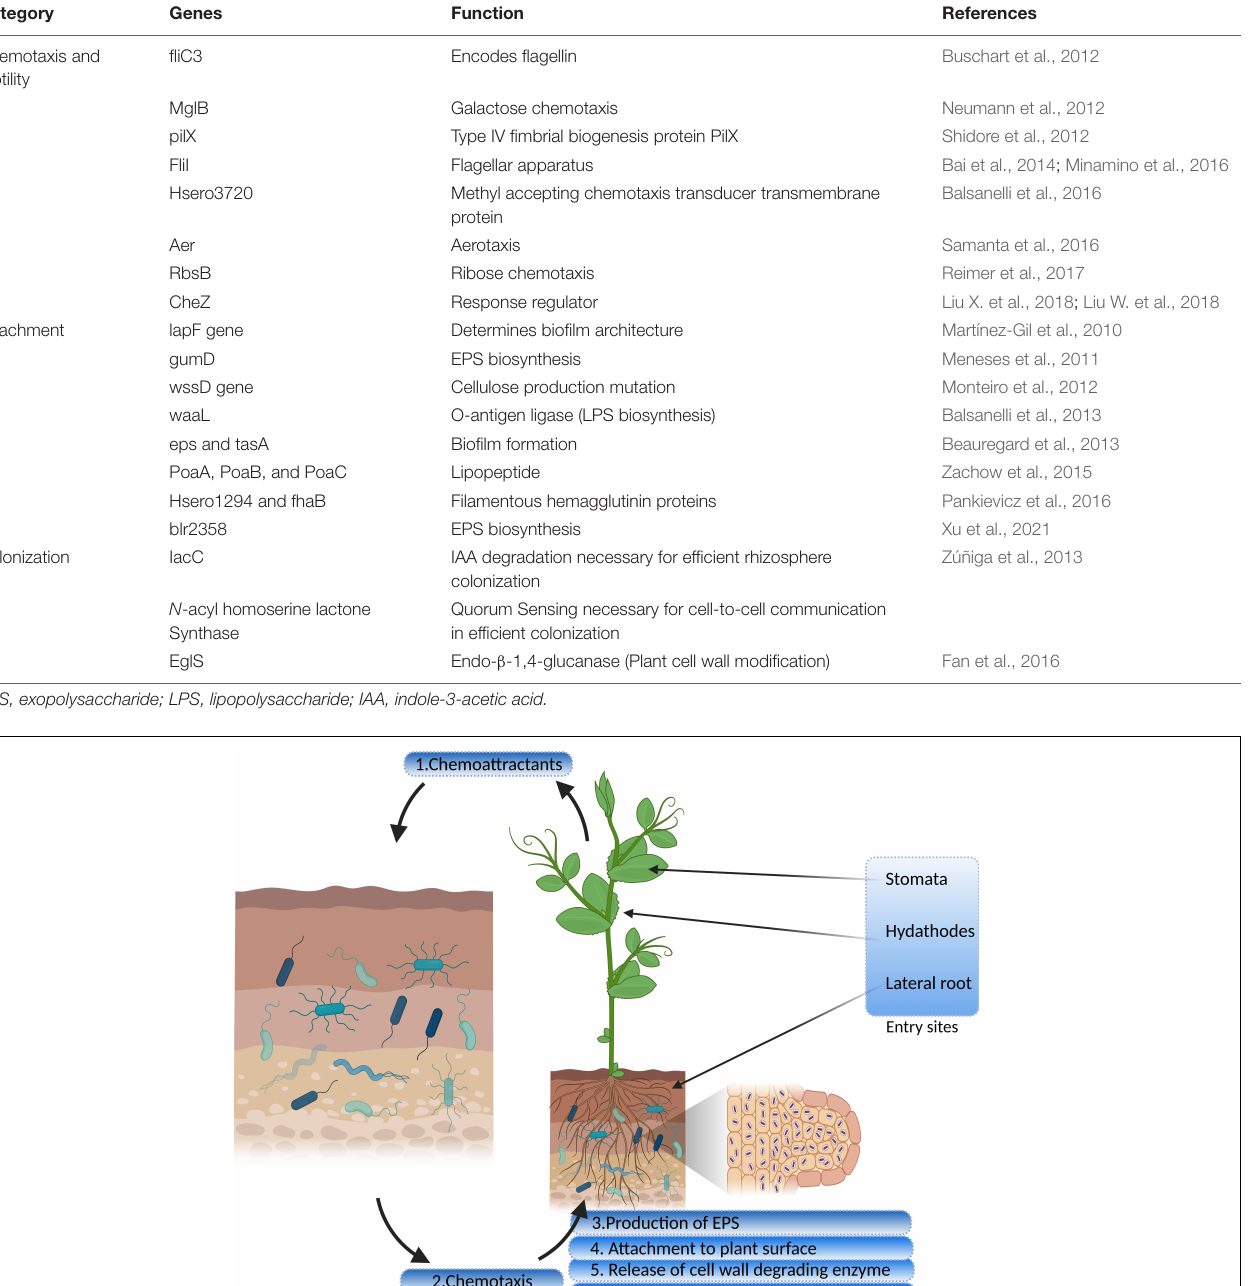
TABLE 1 | Genes involved in colonization of endophytes.